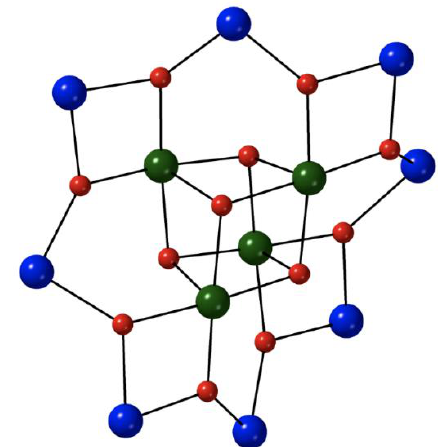
Figure 1. The {Mn III 8 Mn IV 4 ( µ 3 -O) 12 } 16 + core of the archetype Single-Molecule Magnet (SMM) 1 . The Mn III centers are shown with blue color, the Mn IV centers with green color and the oxido ions are shown with red color. The four central Mn IV atoms are weakly ferromagnetically coupled, and the remaining Mn III ··· Mn IV and Mn III ··· Mn III exchange interactions are all antiferromagnetic, with the former much stronger than the latter. As a result, the stronger Mn III ··· Mn IV interactions overcome the weaker Mn III ··· Mn III ones within each triangular Mn III 2 Mn IV subunit of the core, aligning the spins of the outer Mn III atoms all parallel, and thus antiparallel to the central Mn IV atoms; this gives an S = 16 − 6 = 10 ground state.